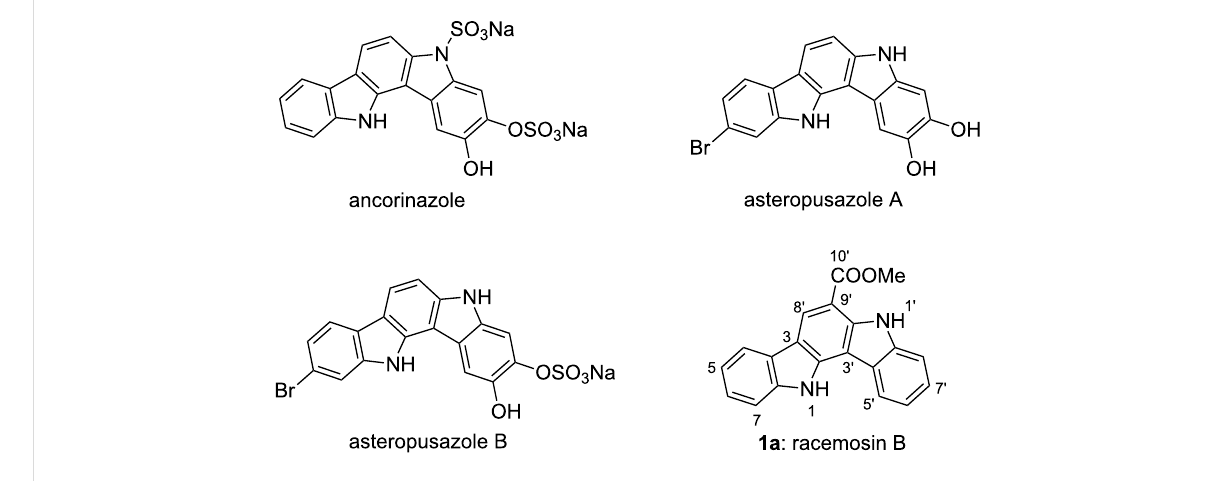
lytically and widely applied as an atom economic approach to carbazoles